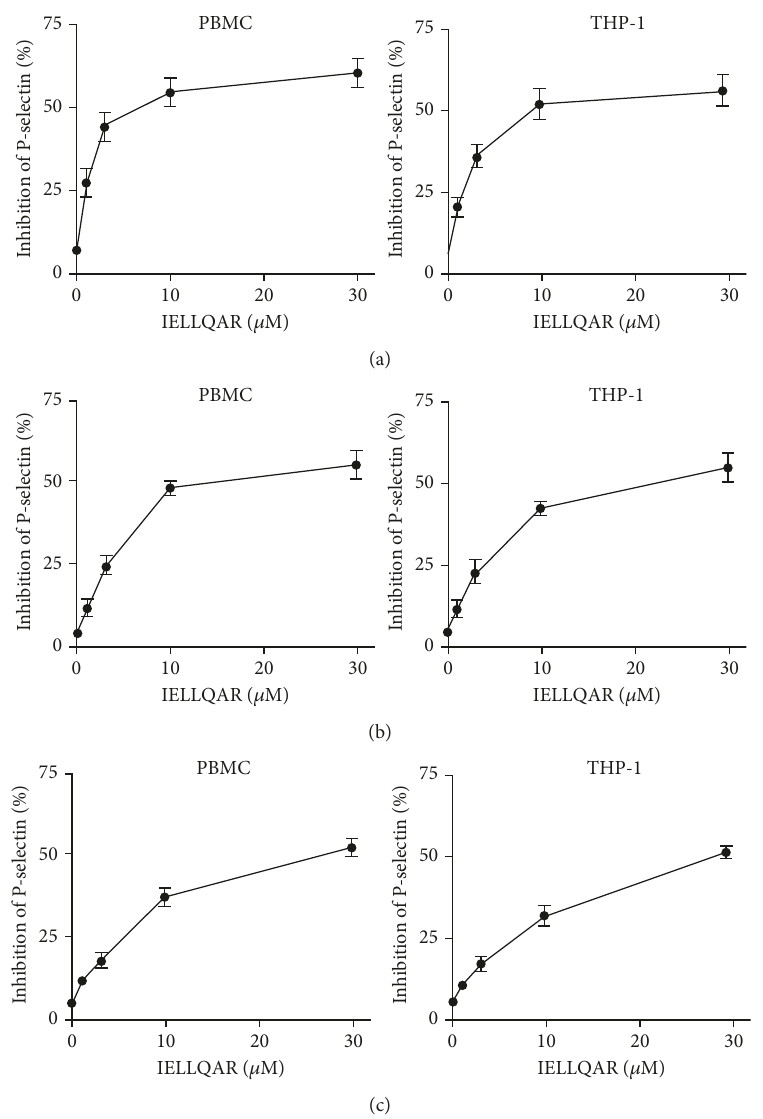
Figure 1: IELLQAR inhibits selectin binding to monocytes. PBMCs and THP-1 cells were incubated with increasing concentrations of IELLQAR (1, 5, and 10 μ M) in the presence of 10 μ g/mL of P-, E-, or L-selectin for 30 min, analyzed by fl ow cytometry, and plotted as the percent inhibition vs. bovine serum albumin (BSA) control. IELLQAR exhibited dose-dependent inhibitory e ff ects against selectin family binding to monocytes, with the highest inhibition of P-selectin binding to PBMCs and THP-1 cells (a), a moderate inhibition of E-selectin (b), and the lowest inhibition of L-selectin (c). Data are presented as the mean ± SEM ( n = 3